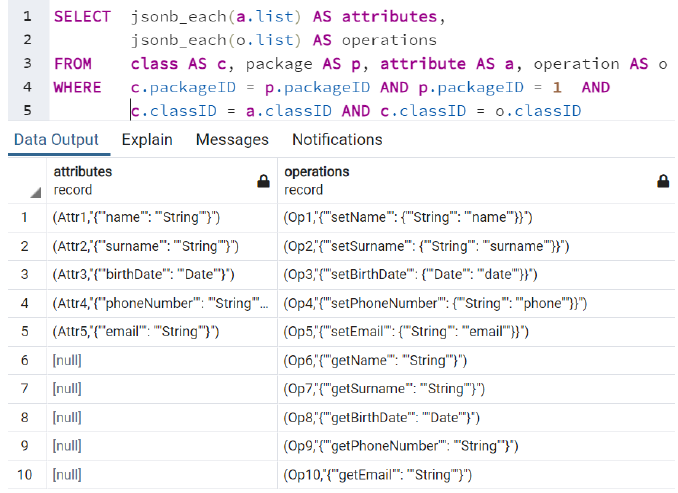
Figure A5. Query 4. It uses the PostgreSQL’s jsonb_each()